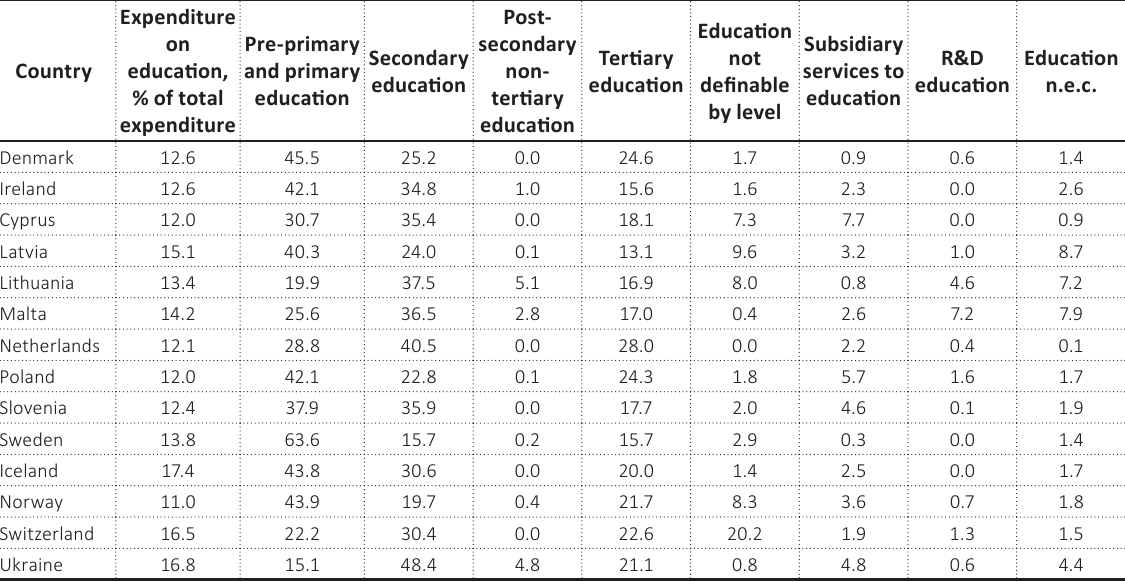
Table 1. The structure of public spending on education in some European countries and Ukraine in 2018 Source: Eurostat (2018), State Treasury Service of Ukraine